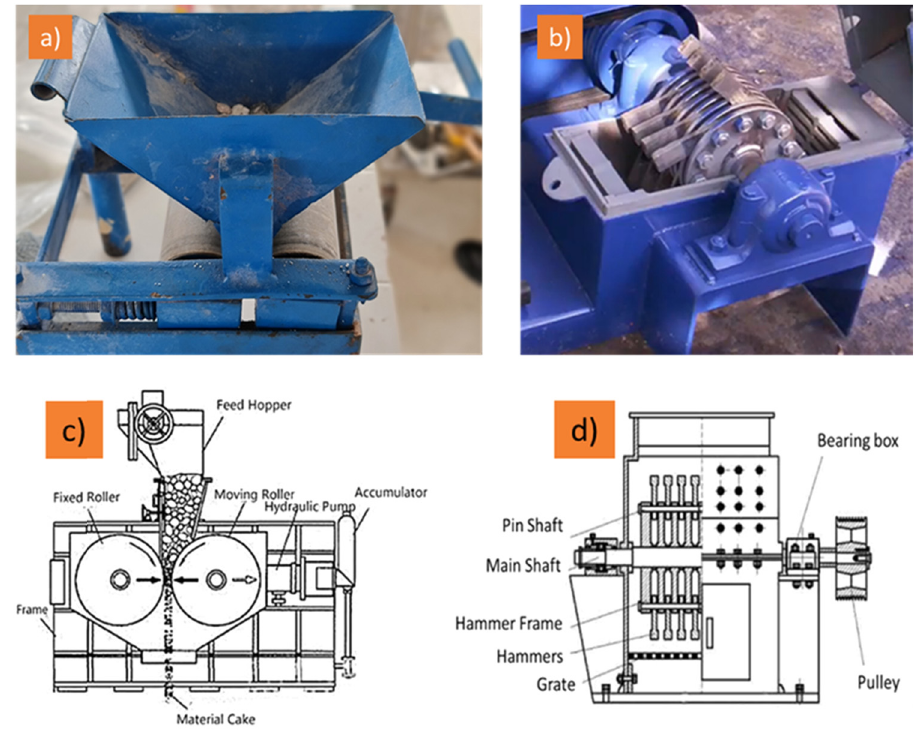
Figure 1: Image of roller press ( a ) and the hammer crusher ( b ) used in experiments and operating principle of roller press ( c ) and the hammer crusher ( d )